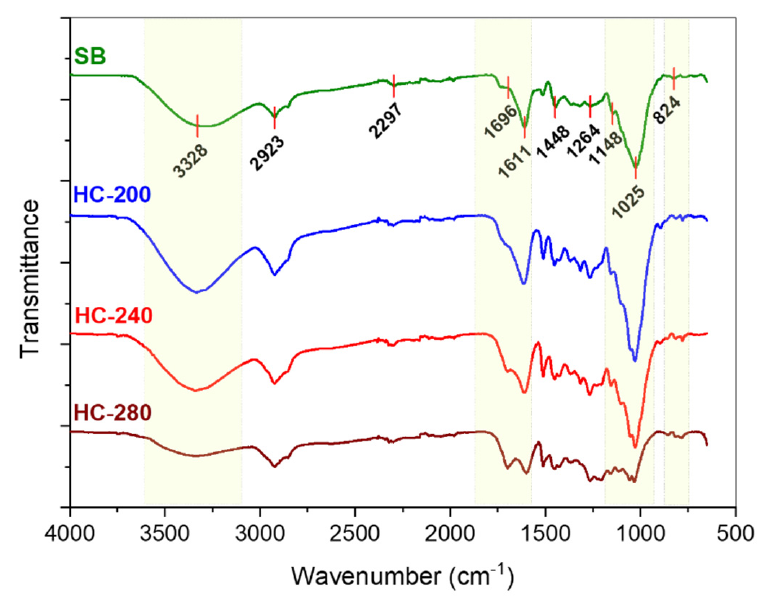
Figure 6. FT-IR spectra of SB, HC-200, HC-240, and HC-280. The wide band between 3500–3000 cm − 1 was characteristic to the stretching vibrations of the O–H bonds. The absorption picks in the range of 2923 cm − 1 and 2297 cm − 1